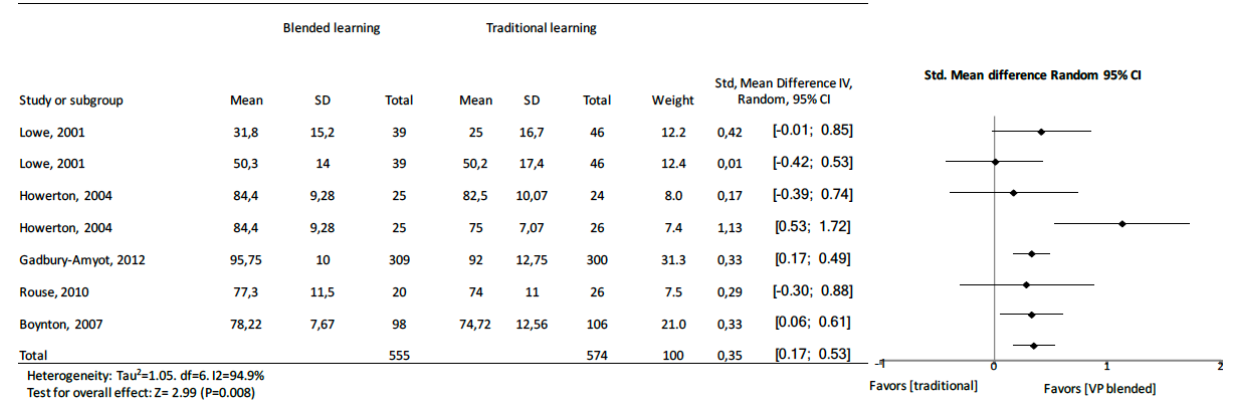
Figure 11. Forest plot of blended learning to traditional learning comparison for knowledge outcomes for dentistry students. df: degree of freedom; CI: confidence